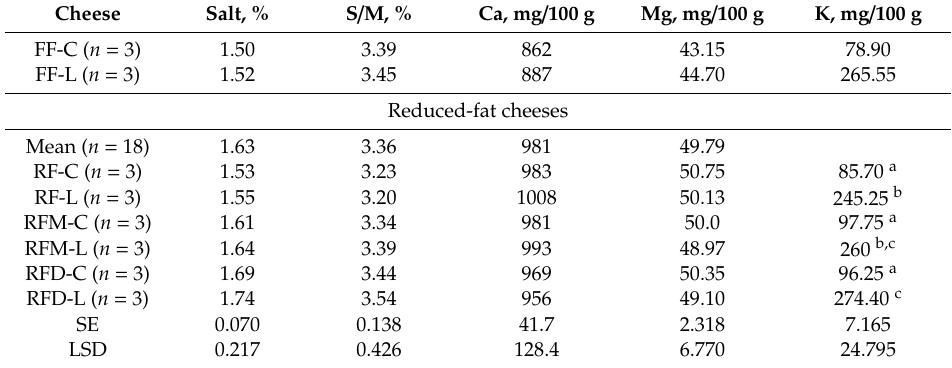
Table 4. Salt (NaCl or NACl / KCl) and particular mineral content of reduced-fat sheep milk cheeses at 60 days of ripening. Cheese codes are according to Tables 1 and